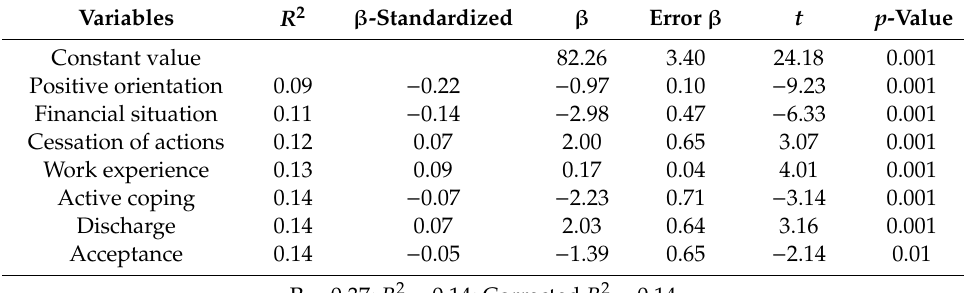
Table 6. Regression summary—predictors of burnout in contacts with